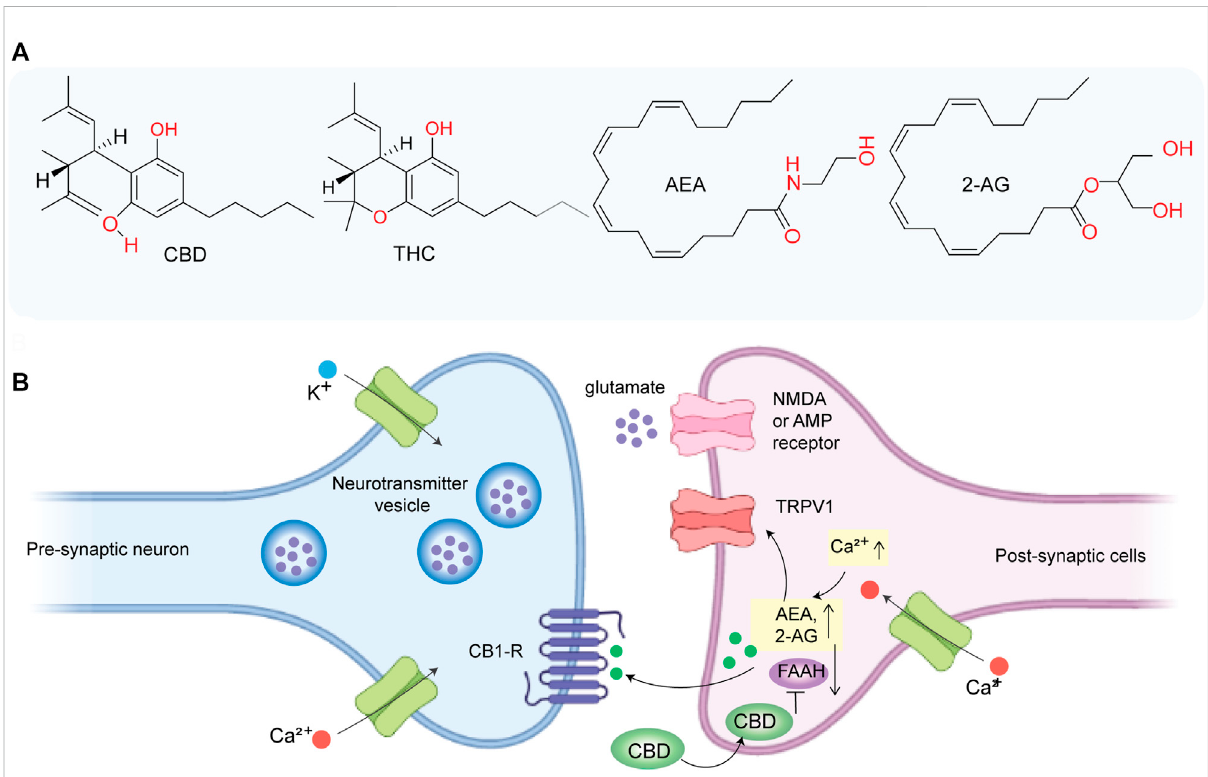
FIGURE 1 (A) Chemical structure of CBD, THC, anandamide (AEA), and 2-arachidonoylglycerol (2AG). (B) CBD indirectly activates CB1 receptor and TRPV1 by inhibiting FAAH and thereby promoting the accumulation of AEA at synapse which may play a role in inhibiting glutamate-based